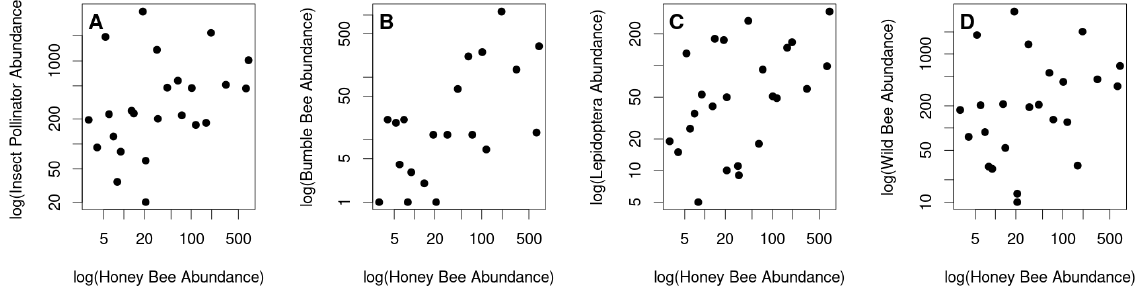
Figure 2. Scatterplot of log honey bee abundance versus log ( A ) flower-visiting insects, ( B ) bumble bee, ( C ) Lepidoptera, and ( D ) wild bee (i.e., all bees minus honey bees) abundance. The abundance of honey bees on a plant positively correlated with the abundance of insect pollinators in general, a relationship largely driven by the correlations between honey bees and Lepidopterans and honey bees and bumble bees but not by the relationship between honey bees and wild bees.